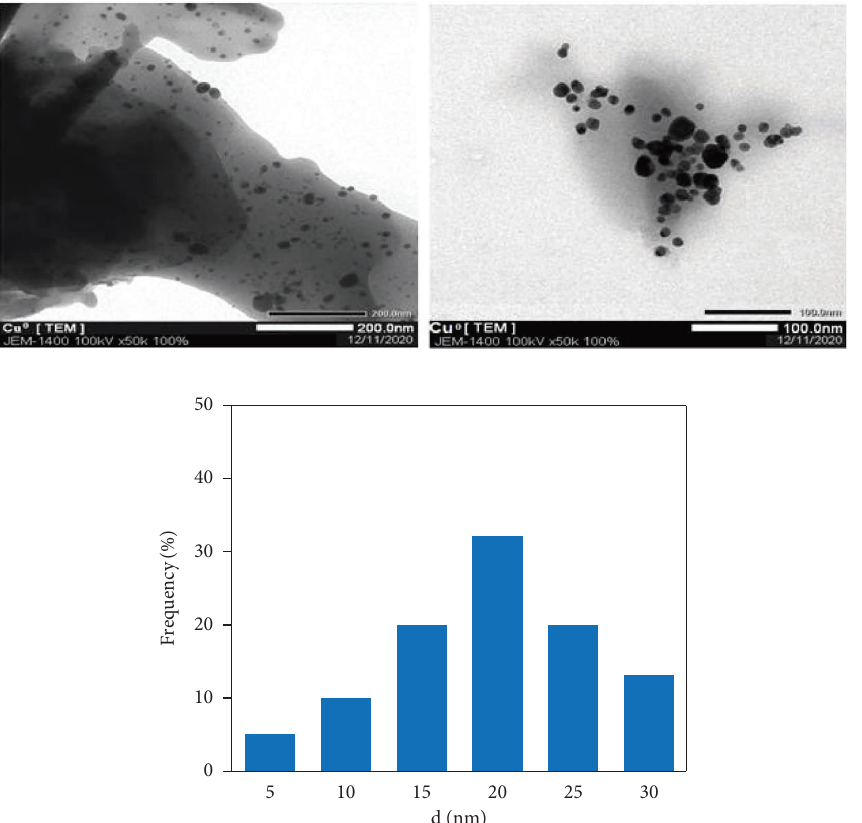
Figure 3: TEM images at diferent scales and particles size distributions of CuNPs/DA.